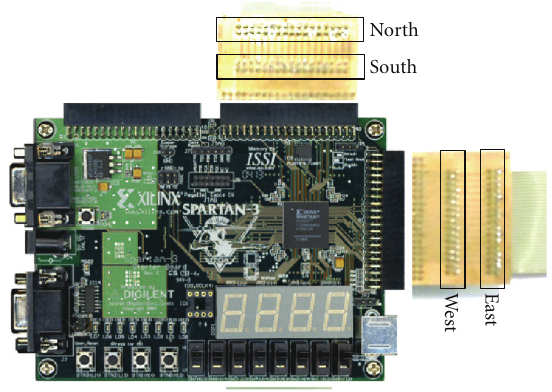
Figure 15: The prototyping